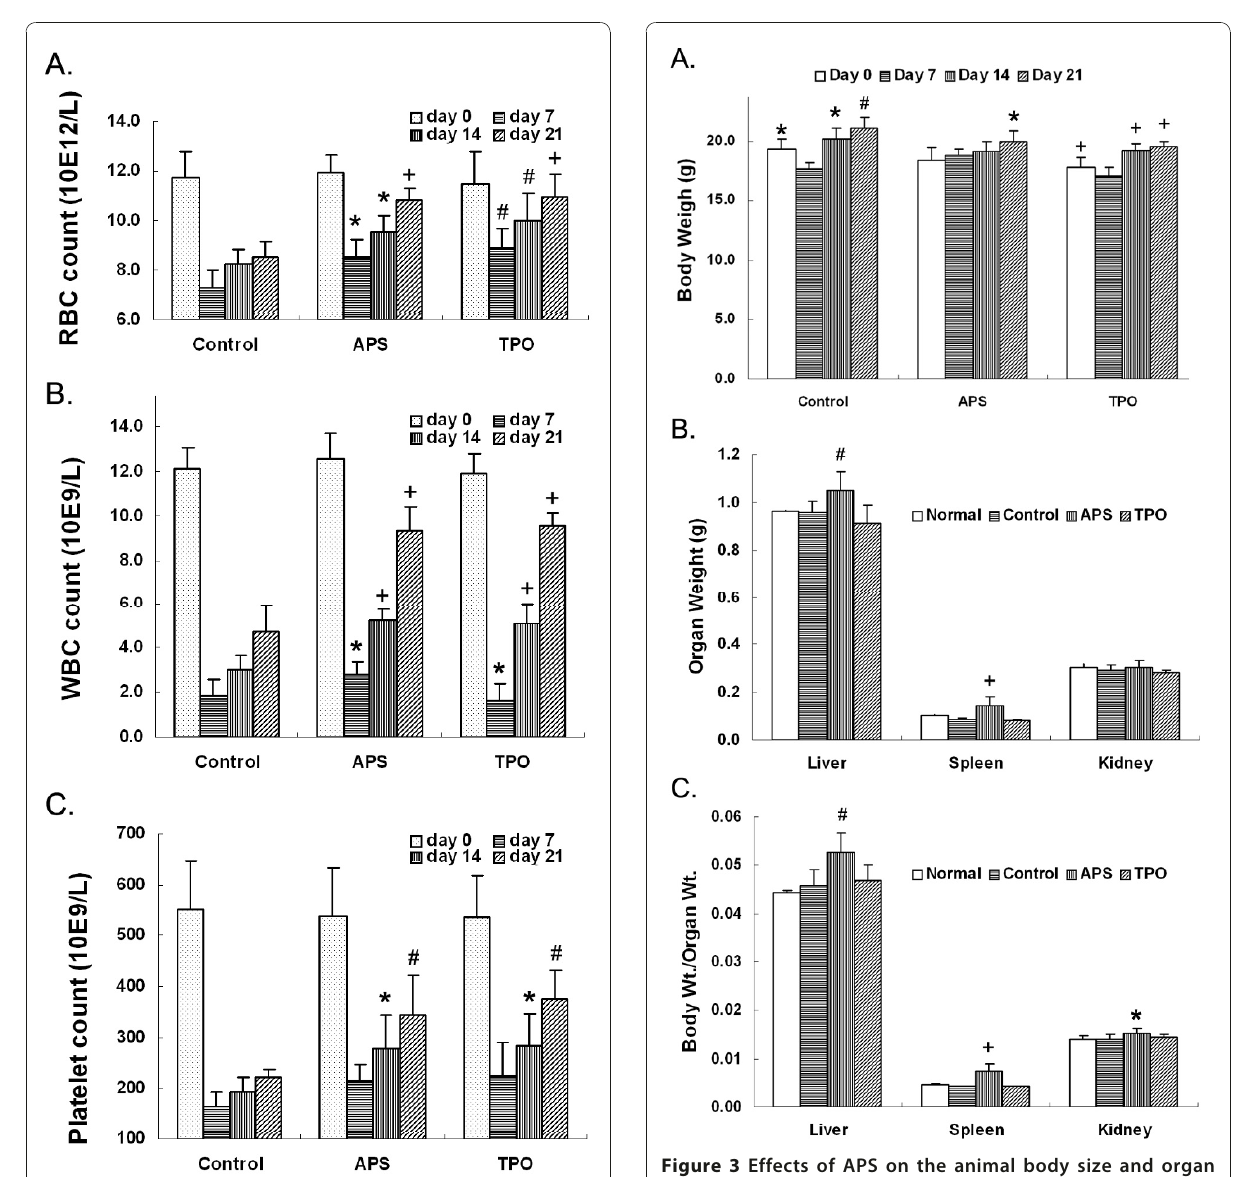
Figure 2 Effects of APS on blood cell counts of irradiated mice model . Mice (n = 6) were irradiated on day 0 and then treated with vehicle (Control), APS (10 mg/kg/day, APS) and TPO (1 ug/kg/ day, TPO). The blood was taken and the numbers of (A). red blood cells (RBC), (B). white blood cells (WBC) and (C). platelets were counted. The statistical tests were carried out on the cell counts between the corresponding tests and the control groups. *: p < 0.05; #: p < 0.01 and +: p < 0.001.